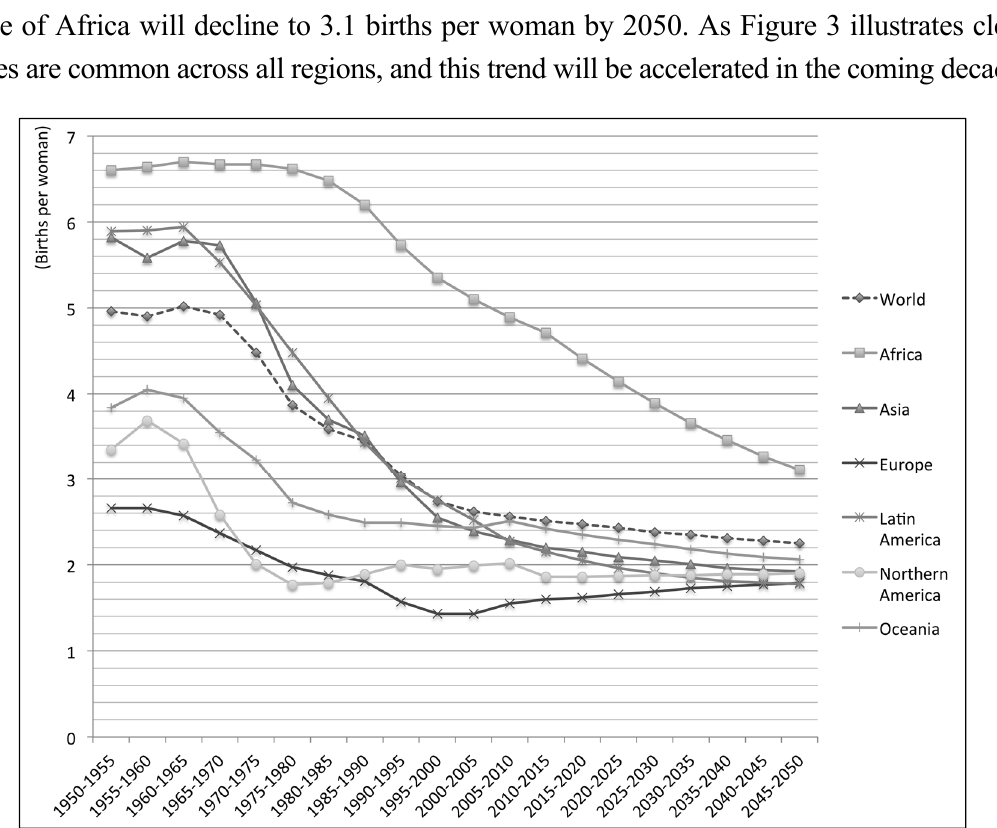
Figure 3. Trends in the total fertility rate in the world and six regions. Note: Created from total fertility estimations for 1950–2010 and projections with a medium fertility variant for 2015–2050 by the United